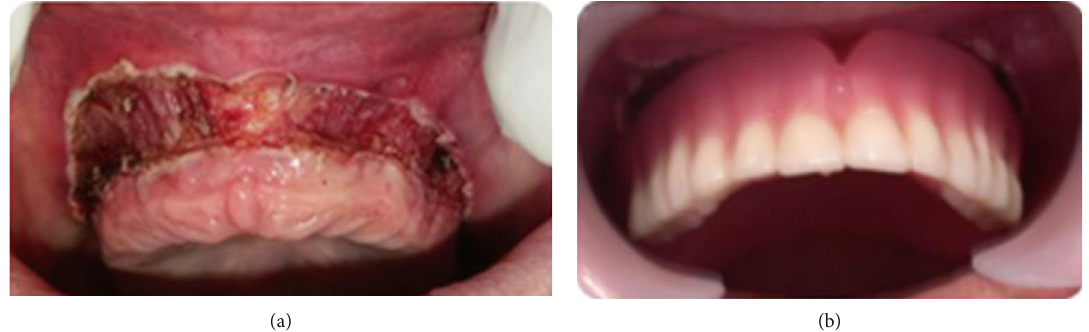
Figure 26: (a) Vestibuloplasty using laser. (b) Surgery control using